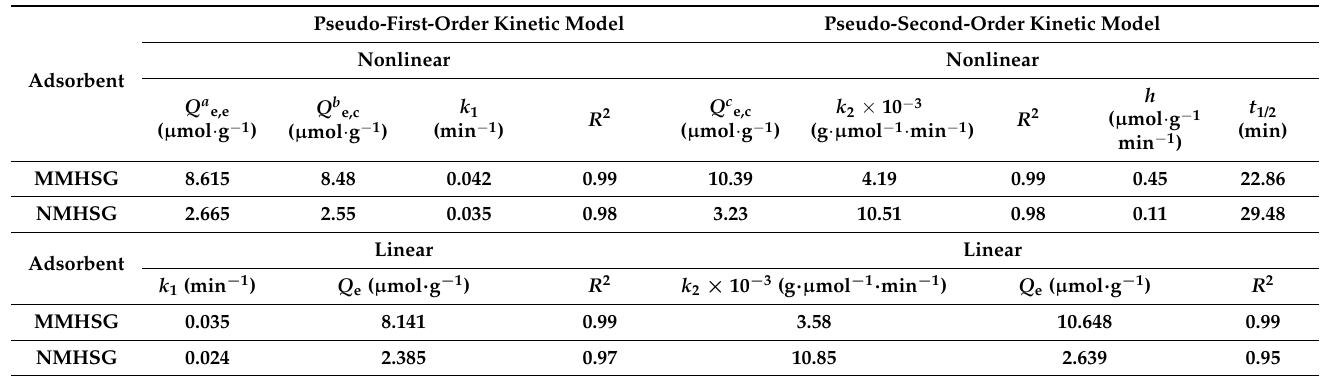
Figure 8. Non-linear kinetic model fitting curves of BHPN@MIPs, BHPN@NIPs, and BHPN for dA ( a ), linear kinetic model evaluation on dA ( b ). Table 1. Adsorption kinetic constants and linear regression values from two models onto MMHSG and